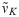
Simulation results of thalassemia major population in both genders with different level of marriage reconsideration rates.(a) Thalassemia female TF with different marriage reconsideration rates. (b) Thalassemia male TM with different marriage reconsideration rates. νK and ν˜K are the marriage reconsideration rates of educated and uneducated carrier populations for K = {M, F}. νK = 0 (νK˜=0) means all of uneducated (educated) carrier males or females do not give up their marriage decision, whereas νK = 1 (νK˜=1) means all of uneducated (educated) carrier males or females do give up their marriage decision due to screening and education. The education and premarital screening rates are as in Table 3.